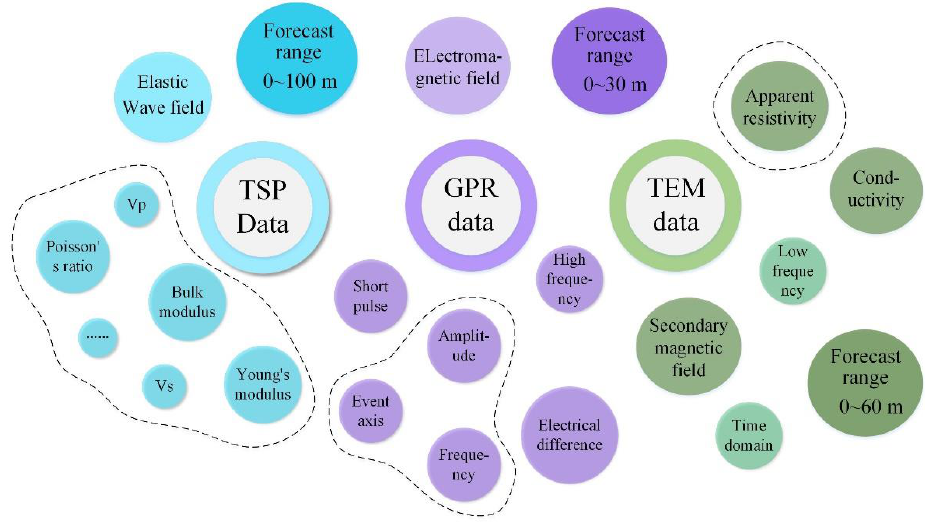
Figure 1. Features of multi-source geophysical data.